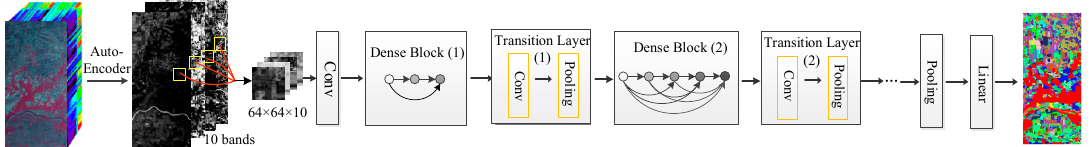
Figure 1. The framework of DenseNet for HSI supervised fine-grained classification.